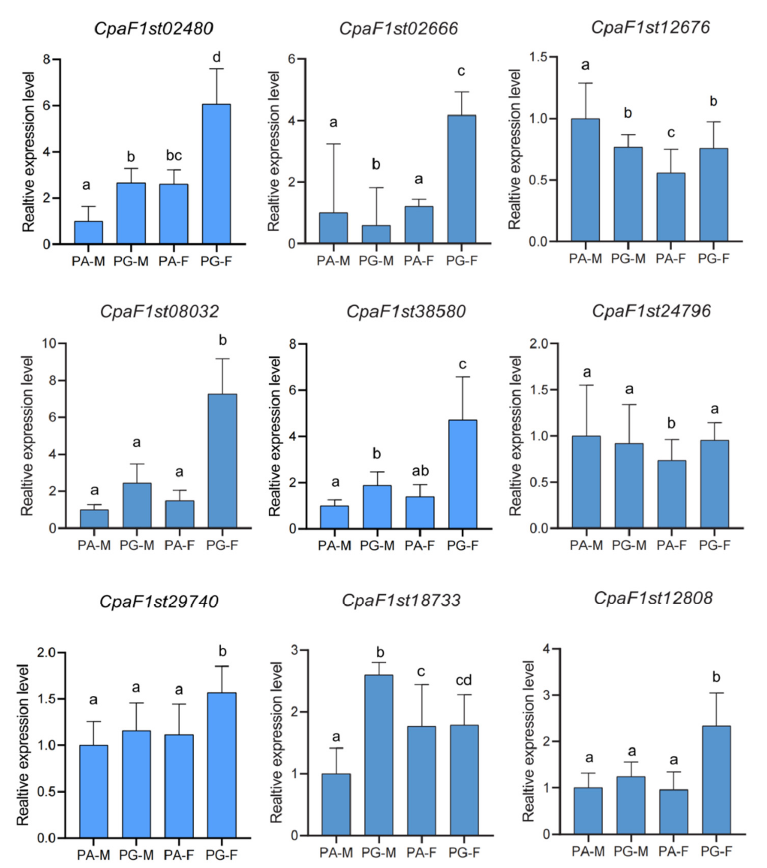
Figure 6. Comparisons of expression levels of nine MIKC-type MADS-box genes obtained by qRT- PCR analysis in different floral buds during germination in C. paliurus . PA-M: male floral buds in protandrous type; PG-M: male floral buds in protogynous type; PA-F: female floral buds in protandrous type; PG-F: female floral buds in protogynous type. All RT-qPCRs for unigenes were accomplished in triplicate, with two repeats per experiment. Error bars indicate SD, and different lowercase letters (a–d) represent significant differences among the three samples at p < 0.05.